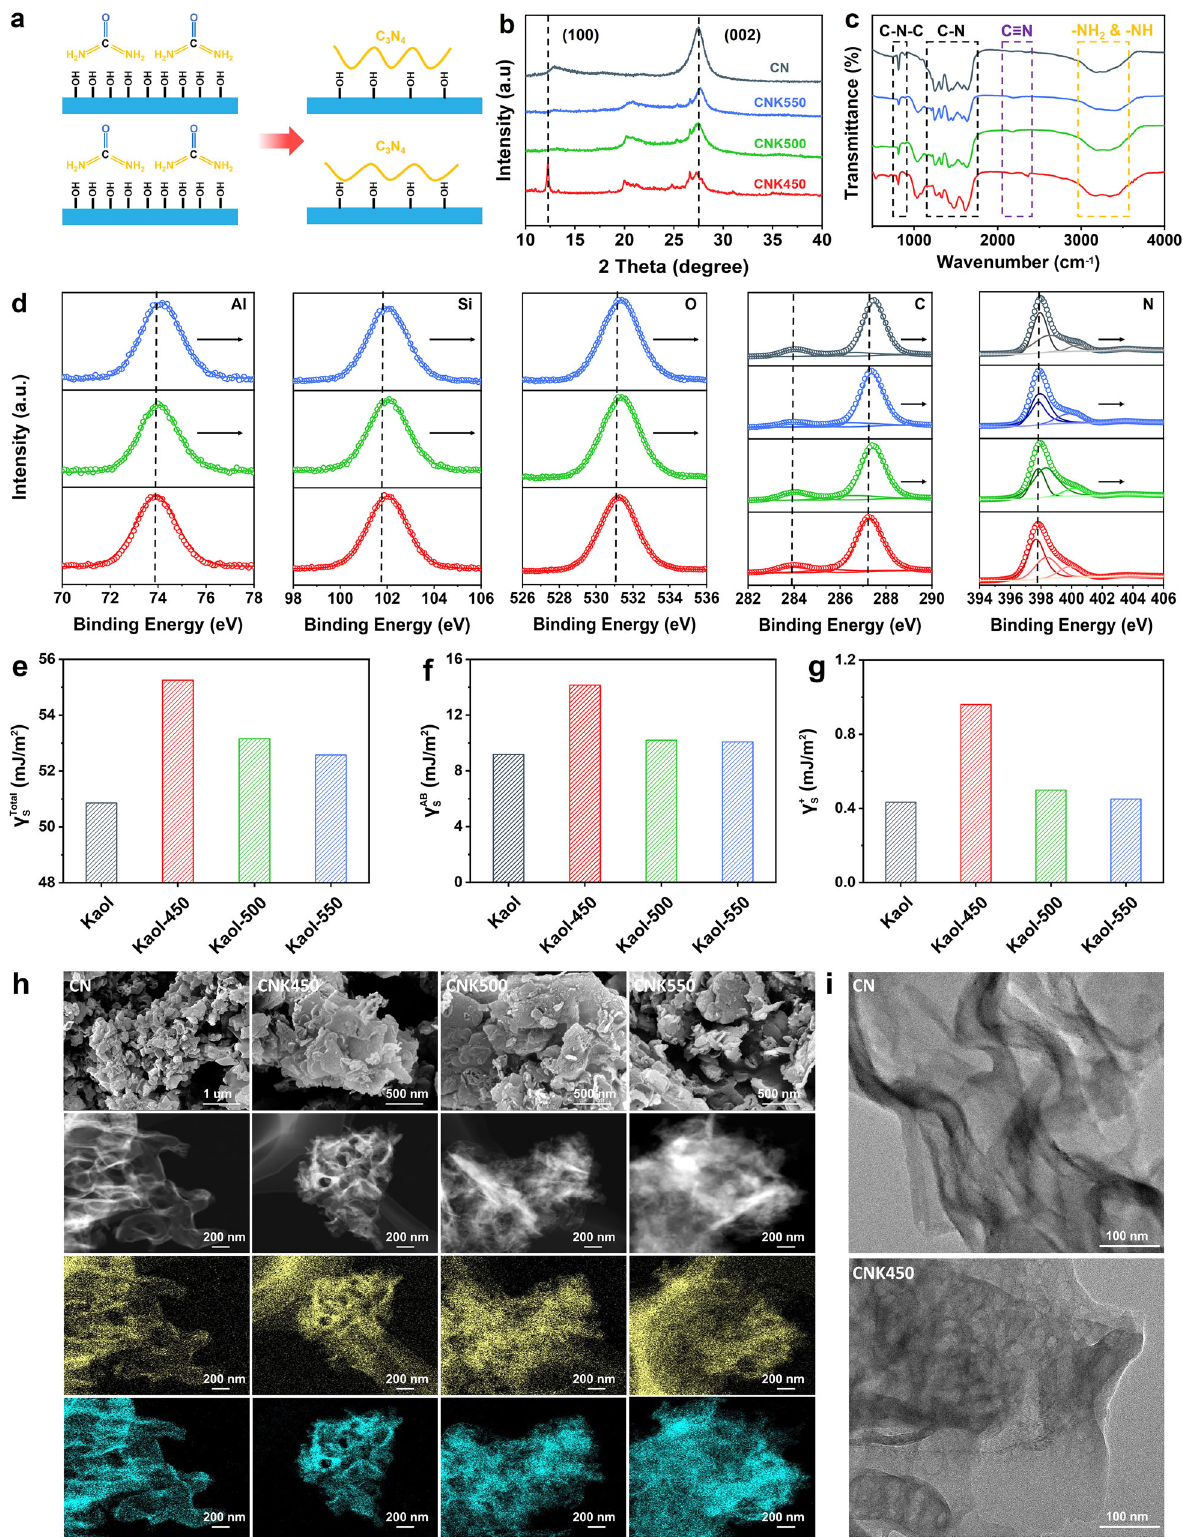
Fig. 1 Characterization of different samples. a Schematic of the sample preparation. b XRD patterns. c FTIR spectra. d Al, Si, O, C, and N XPS spectra of CNK450, CNK500, CNK550, and CN (inset arrow represents the peak shift). Surface free energy of e total surface free energy, f Lewis acid-base surface free energy, and g Lewis acid surface free energy. h Typical SEM and TEM images with the distribution of the mapping images of CNK450, CNK500, CNK550, and CN. i HRTEM images of CN and CNK450 morphology.